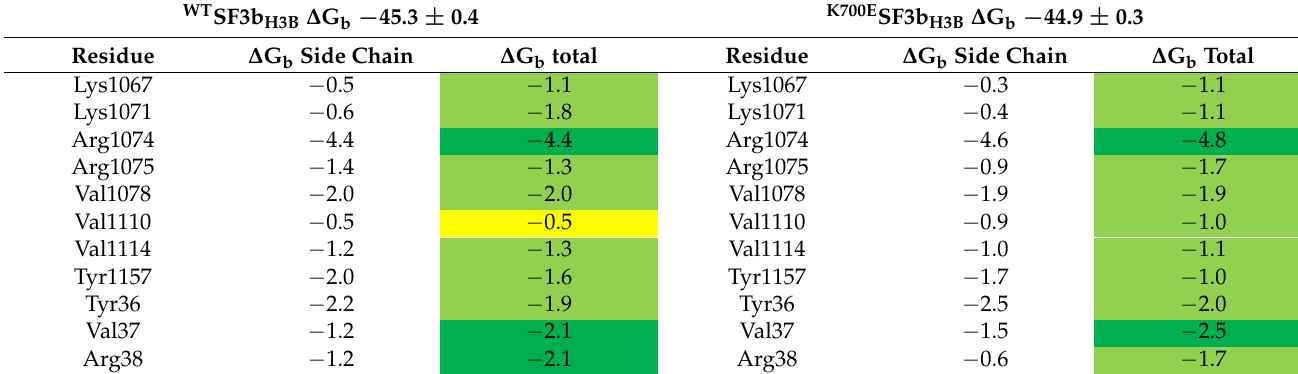
Table 1. Binding free energies ( ∆ G b, kcal/mol) of H3B-8800 to SF3b complex containing wild type ( WT SF3b H3B ) and K700E SF3B1 ( K700E SF3b H3B ) and their per-residue decomposition (kcal/mol) calculated with the Molecular Mechanics Generalized Surface Area (MM-GBSA) method [26]. Residues involved in the stabilization of the H3B-8800 binding pose are marked in yellow, in light green, and in dark green when their contribution to ∆ G b is smaller than − 1.0 kcal mol, when it ranges between − 1.0 and − 2.0 kcal/mol, and when it is larger than − 2.0 kcal/mol, respectively. Standard errors of mean are smaller than 0.1